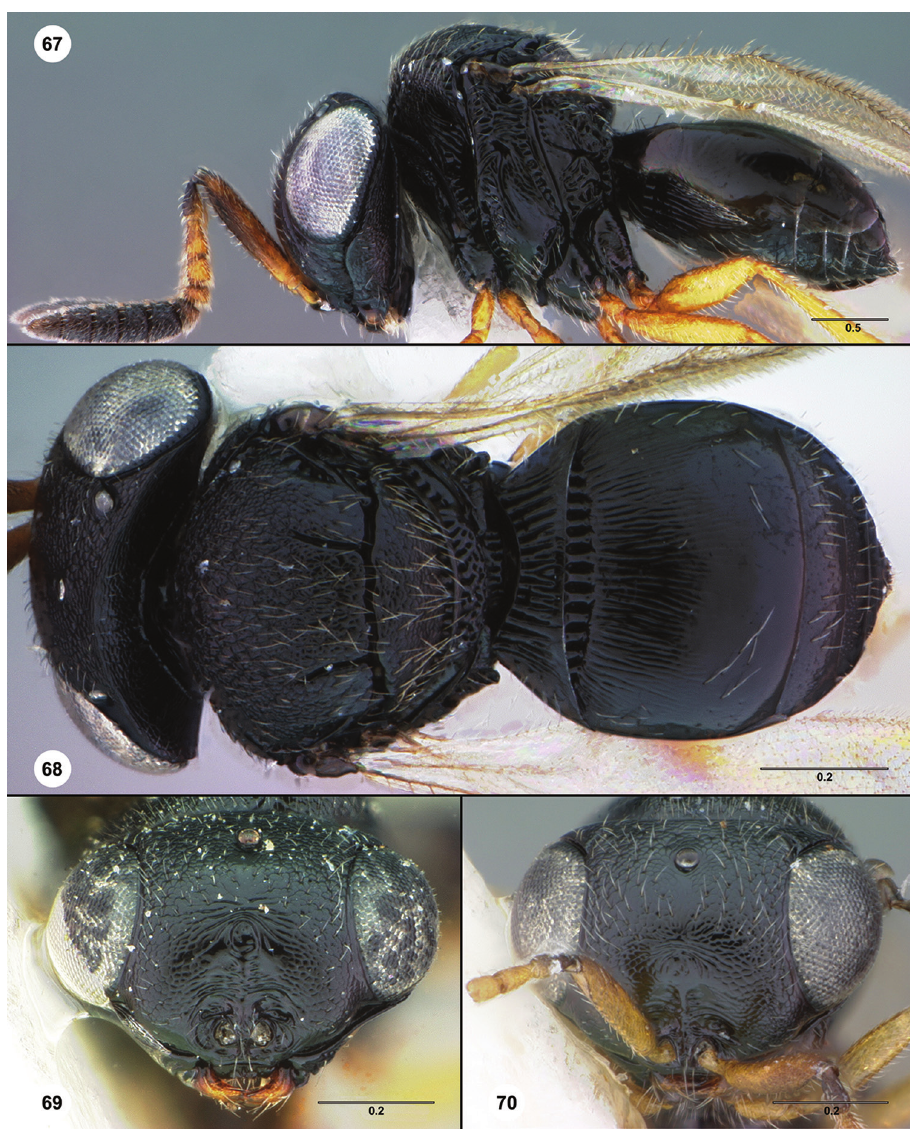
Figures 67–70. Trissolcus flavipes 67 female (USNMENT00916409), head, mesosoma, metasoma, lat- eral view 68 female (USNMENT00916409), head, mesosoma, metasoma, dorsal view 69 female lecto- type (NHRS-HEVA 000002617), head, anterior view 70 female (holotype of T. circus ) (ZMAS 0143), head, anterior view. Scale bars in millimeters. of clypeal setae: 2. Microsculpture on gena directly above mandibular condyle: present. Shape of ventral gena in lateral view: narrow. Genal carina: absent. Malar striae: absent. Sculpture of malar sulcus: antero-posteriorly striate. Orbital furrow: medially delim- ited by ridge or carina at midpoint of eye, poorly defined or absent near